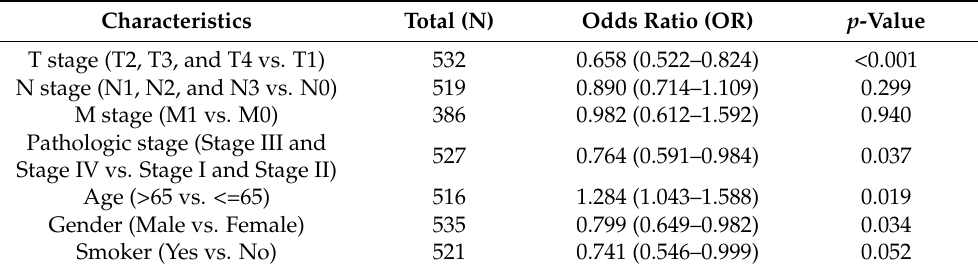
Figure 3. Clinical significance of KCNAB2 in LUAD. Correlation between KCNAB2 expression and clinical parameters, including ( A ) pathological stage, ( B – D ) TNM stage, ( E ) primary therapy outcomes, ( F ) gender, ( G ) age, and ( H ) smoker. Primary therapy outcome: PD, progressive disease; SD, stable disease; PR, partial response; CR, complete response. * p < 0.05, *** p < 0.001. Table 2. The results of the logistic regression analysis of